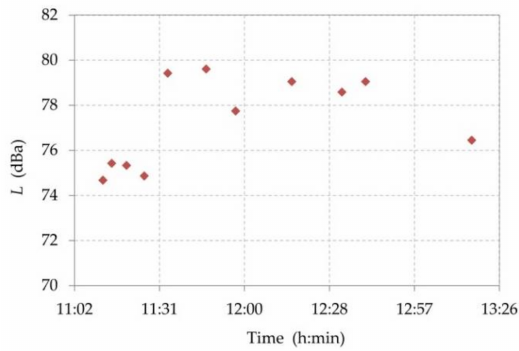
Figure 10. Acoustic pressure